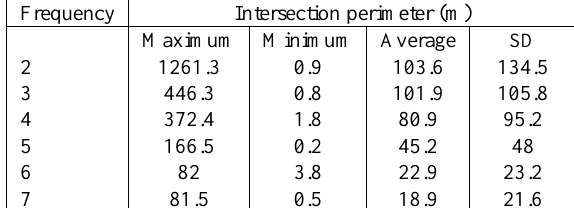
Figure 5. The location of the city of Babolsar and the citizen- proposed areas for the restaurant's establishment.